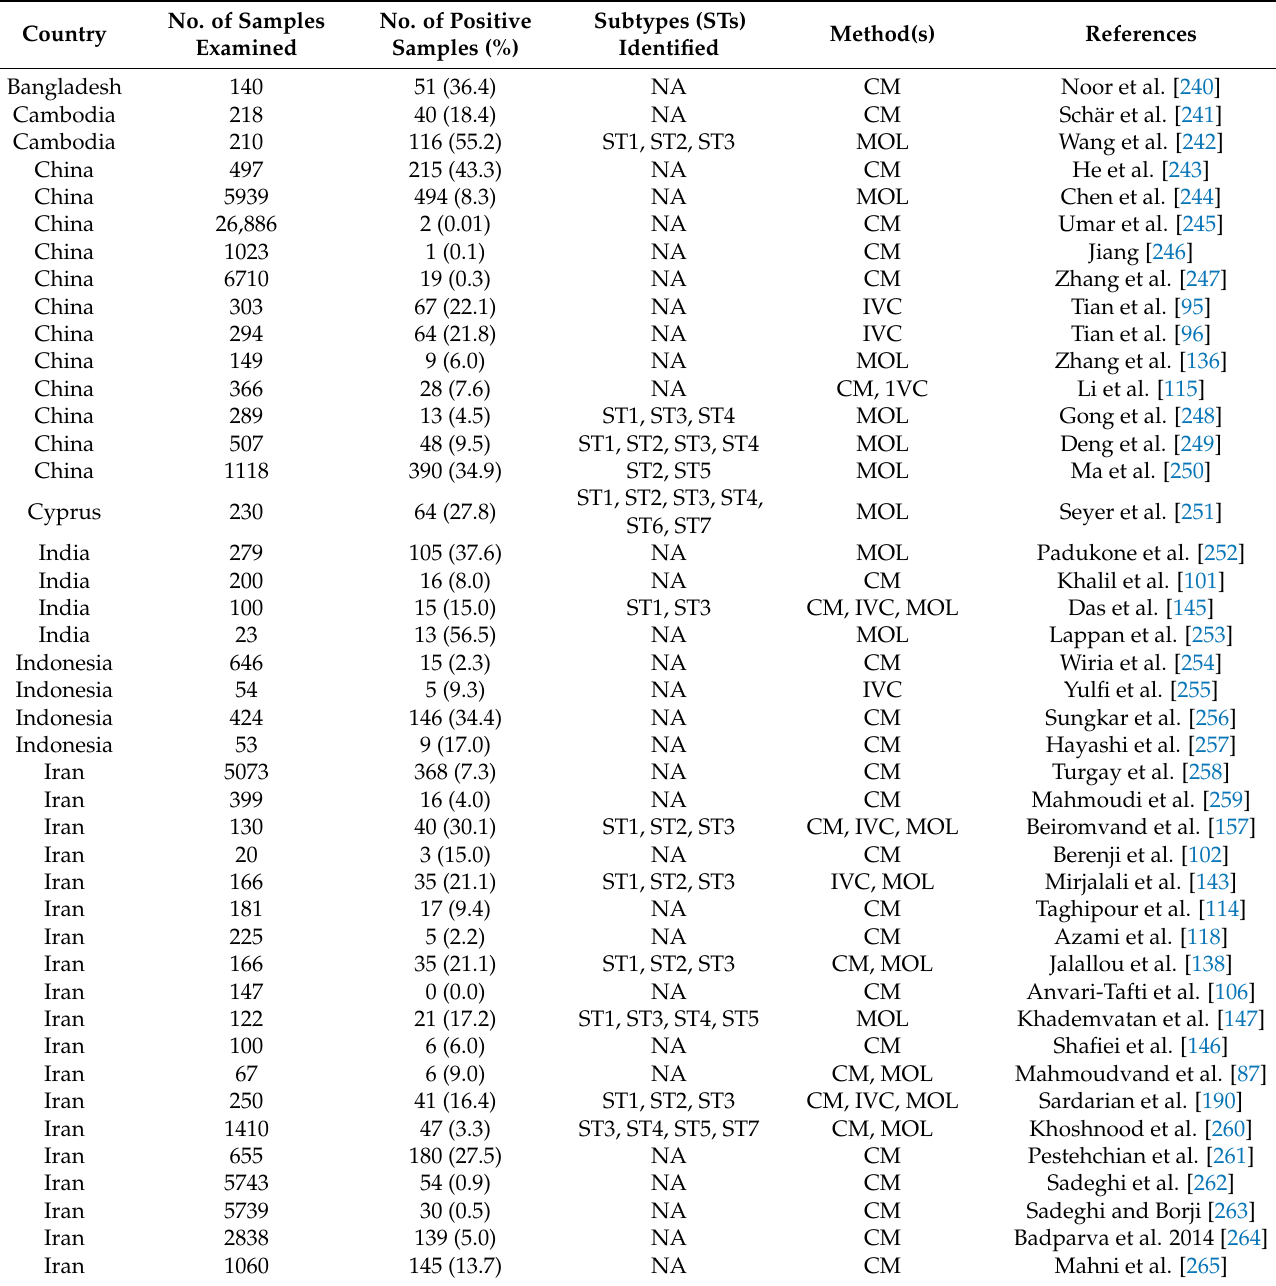
Table 7. Prevalence and subtype distribution of Blastocystis spp. in apparently healthy general populations in Asia